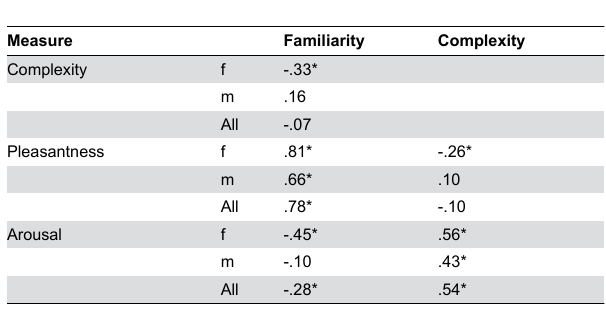
Table 5. Spearman’s rank-order correlations between ratings of familiarity, complexity, pleasantness and arousal in response to representational paintings (N 89, n ≥ 89). females